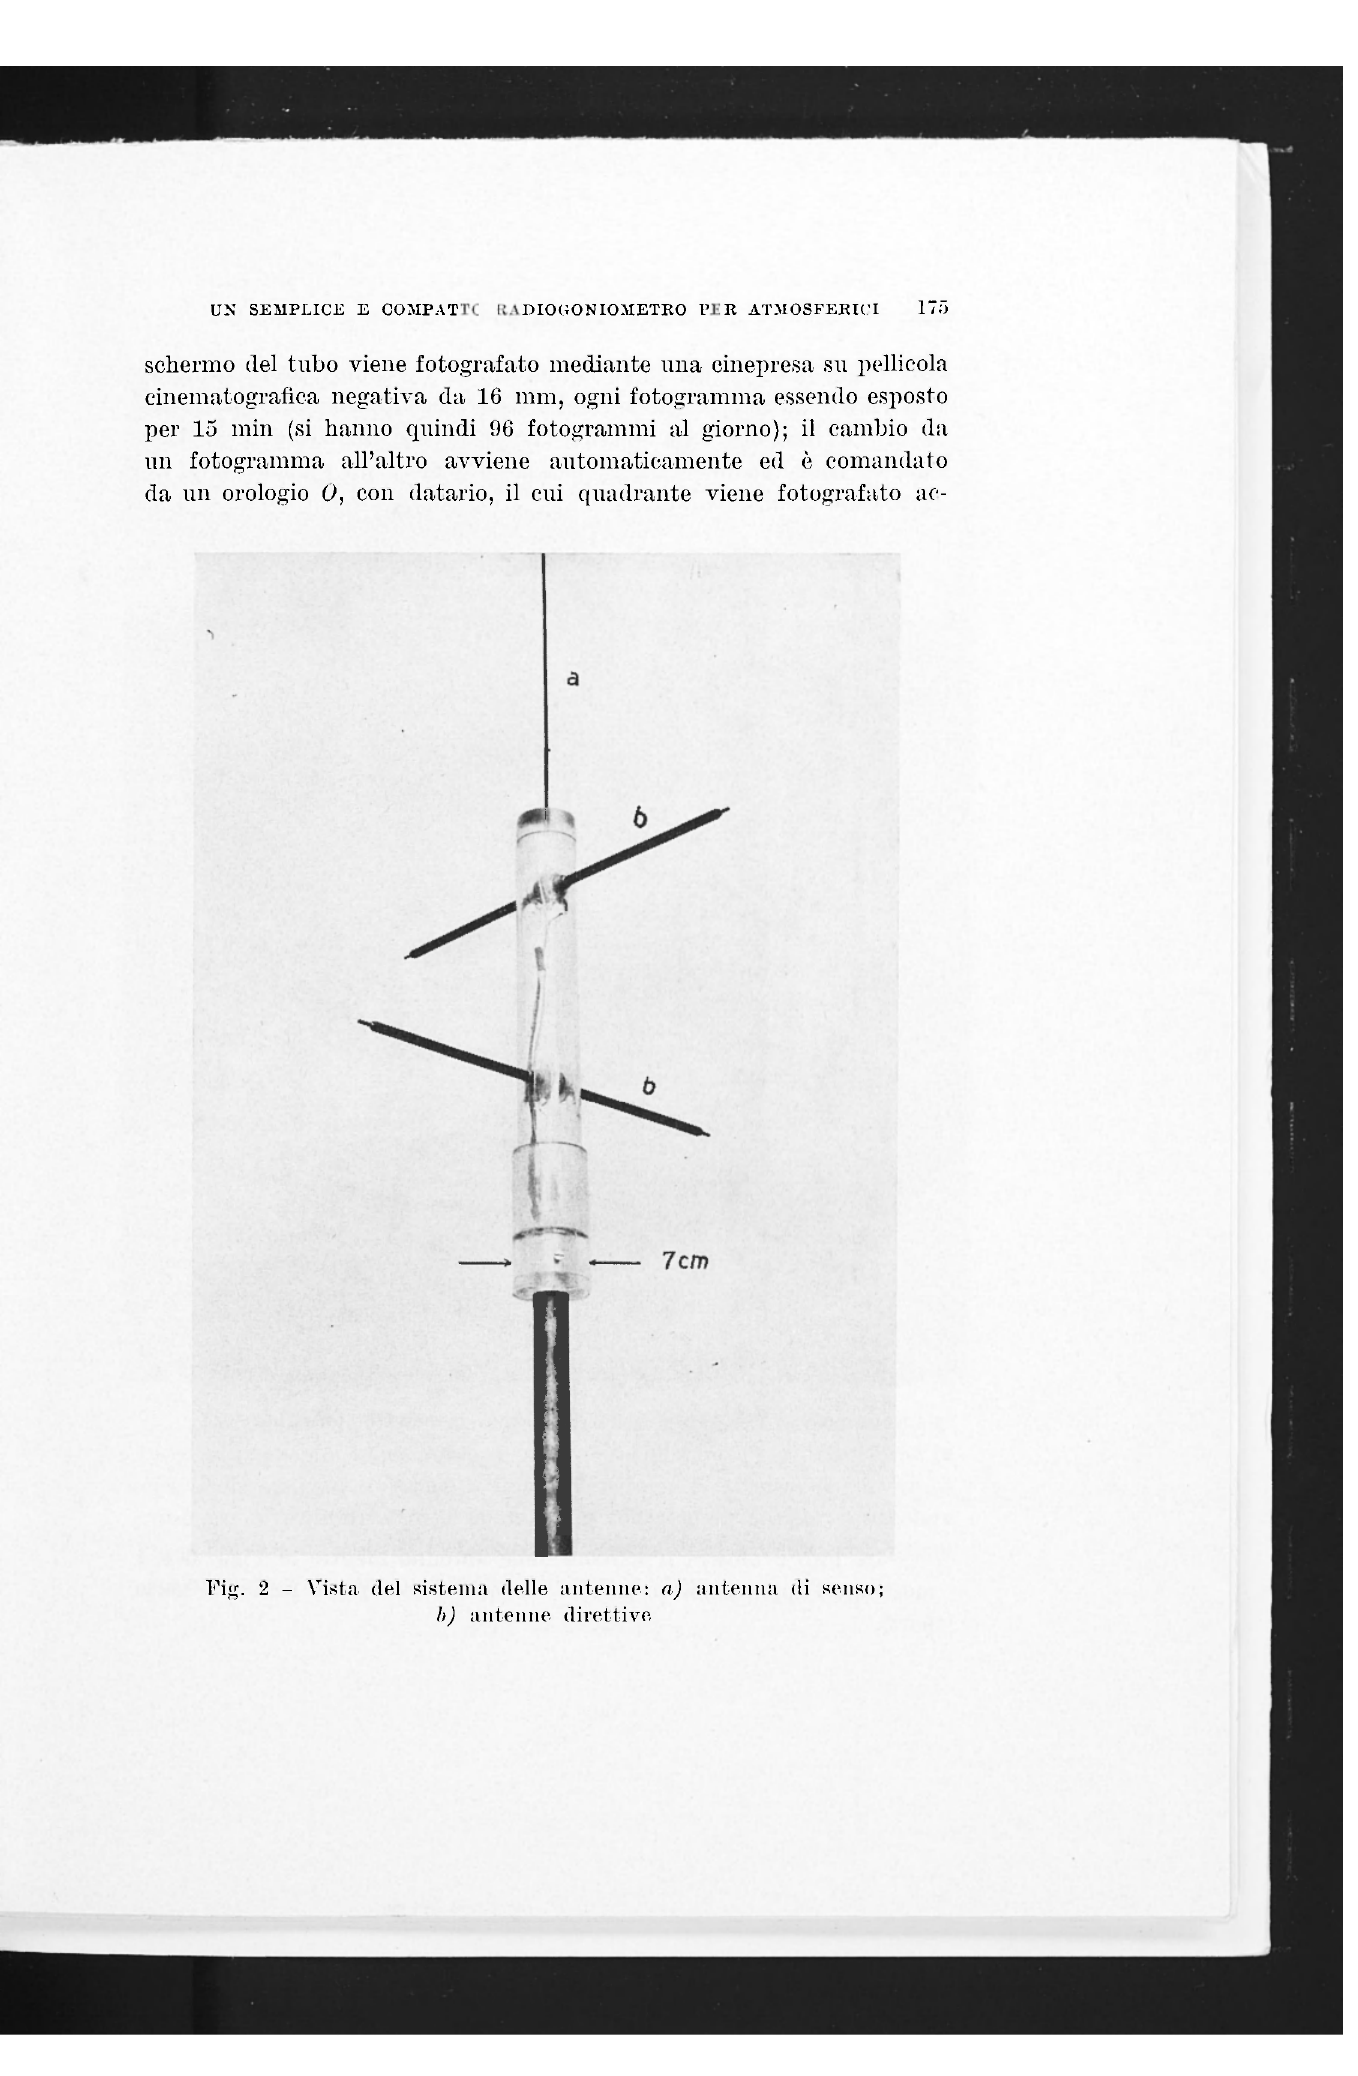
Fig. 2 - Vista del sistema delle antenne: a) antenna di